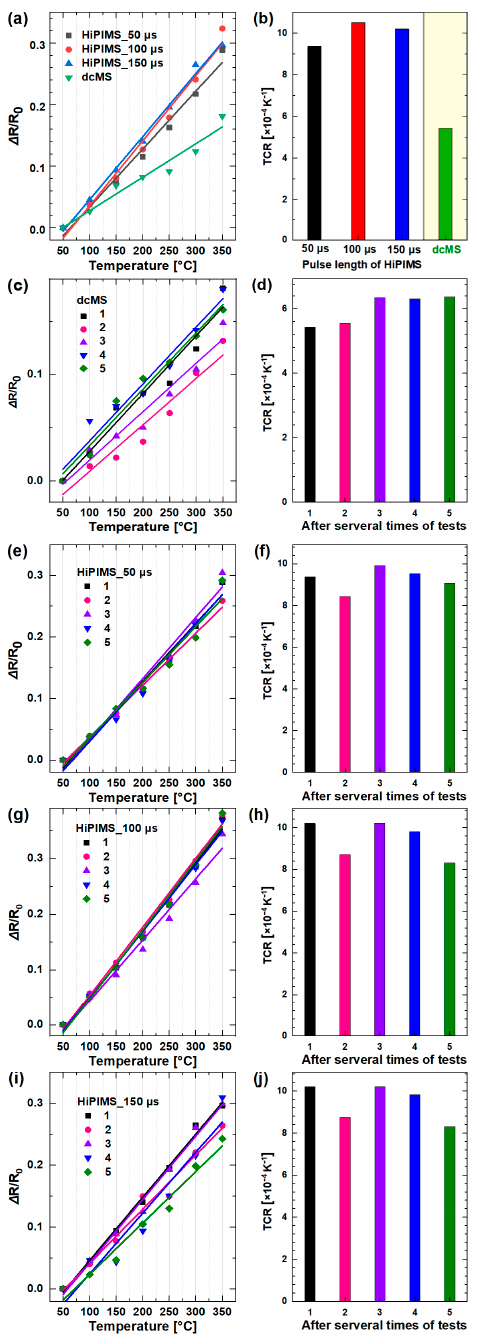
Figure 5. Thermal resistance test results of W thin films prepared by dcMS and HiPIMS. ( a ) Variation of electrical resistivity Δ R/R 0 of W thin films with respect to temperature, ( b ) TCR values of W thin films. ( c ) Variation of electrical resistivity ∆ R/R 0 of dcMS-W thin film with respect to test numbers, ( d ) TCR values of dcMS-W thin film with respect to test numbers. ( e ) Variation of electrical